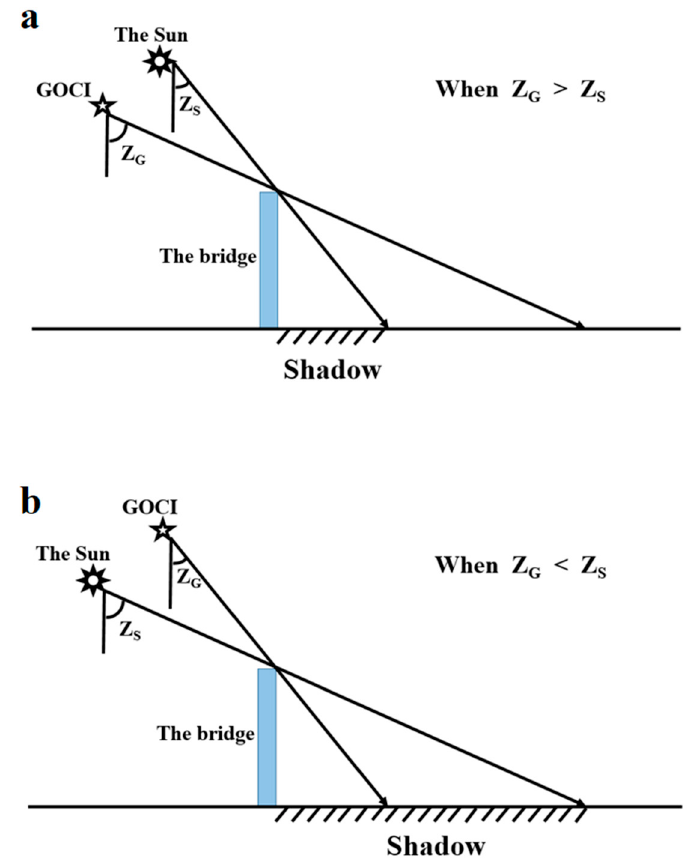
Figure 4. The bridge shadow from GOCI viewed when the zenith angle of GOCI ( Z G ) is: ( a ) larger than the zenith angle of the sun ( Z S ); and ( b ) smaller than Z S .